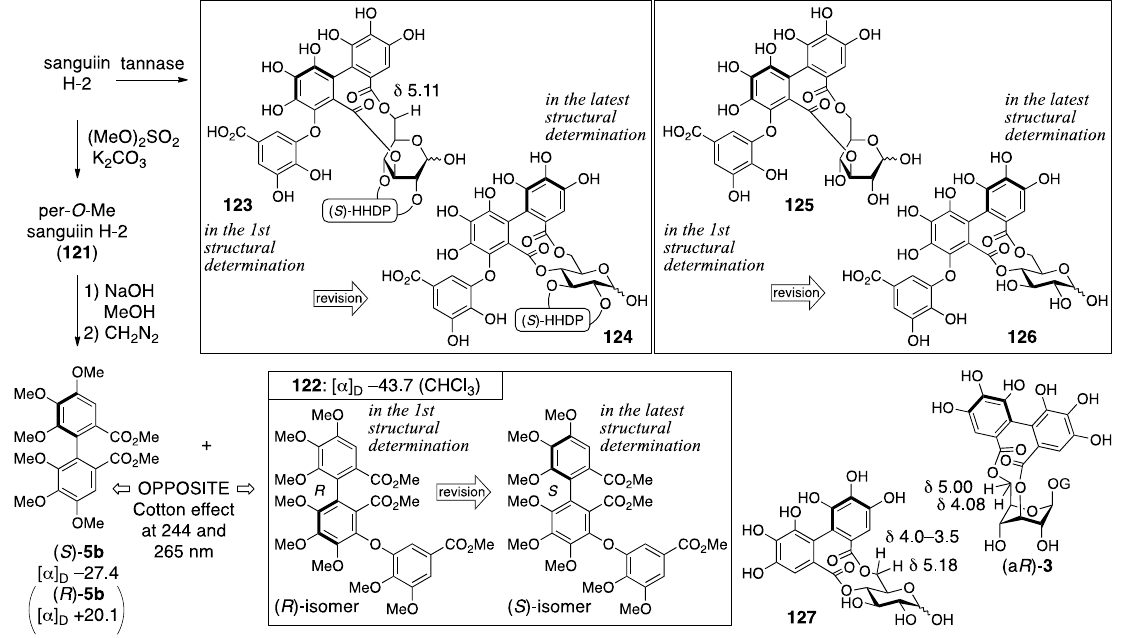
Figure 44. The observations used for the structural determination of sanguiin H-2 ( 115 ). The conformation of the glucose moiety of 123 and 125 was undetermined.